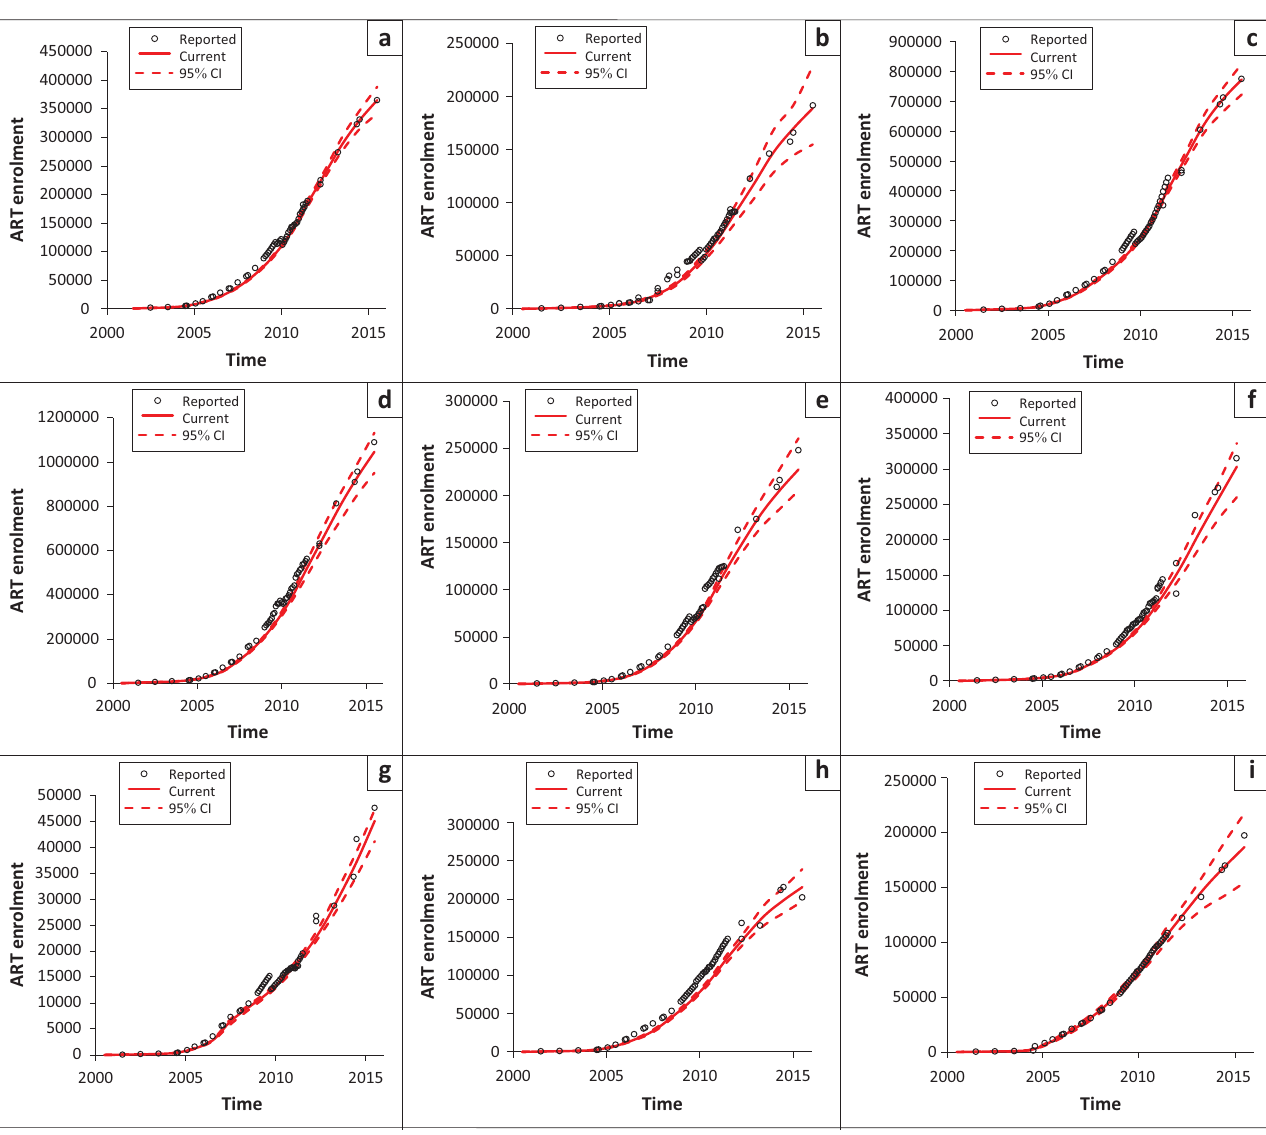
FIGURE 2: Posterior estimates of current antiretroviral treatment enrolment compared with reported antiretroviral treatment totals (adults and children combined): (a) Eastern Cape; (b) Free State; (c) Gauteng; (d) KwaZulu-Natal; (e) Limpopo; (f) Mpumalanga; (g) Northern Cape; (h) North West; (i) Western